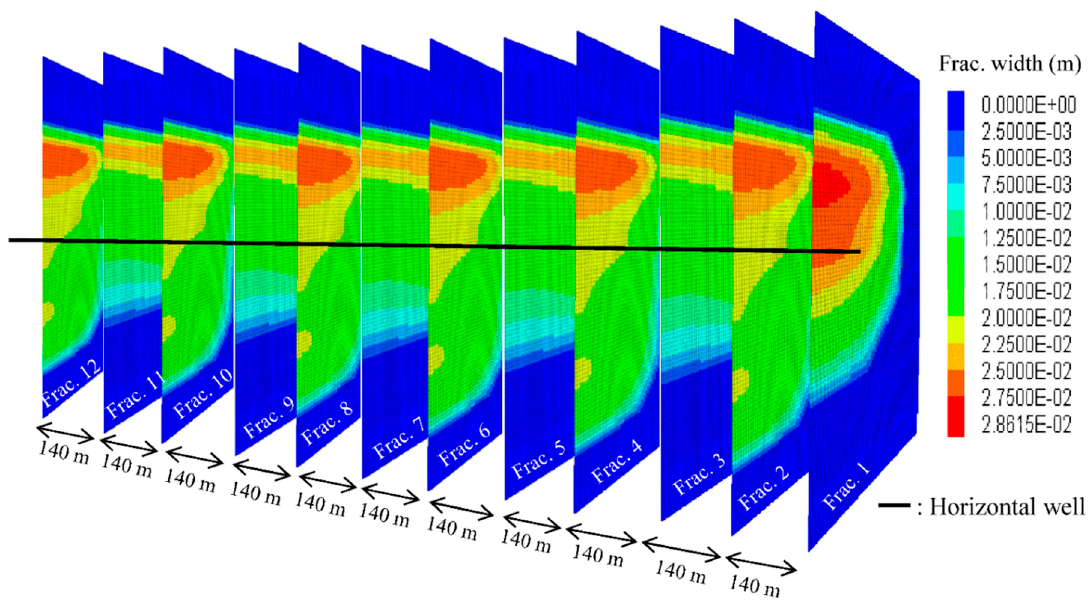
Figure 20. Schematic of projected 12-fracture pattern for geothermal exploitation with 140 m fracture spacing.